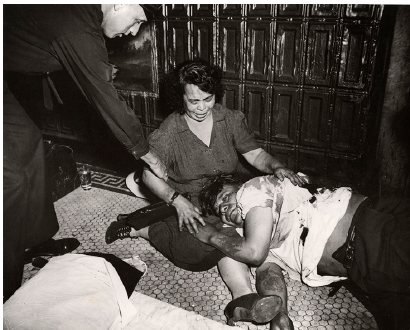
Figure 9. Weegee, [Manuel Jiminez lies wounded in the lap of Manuelda Hernandez, New York], July 29, 1941. © Weegee/International Center of Photography (163.1982).